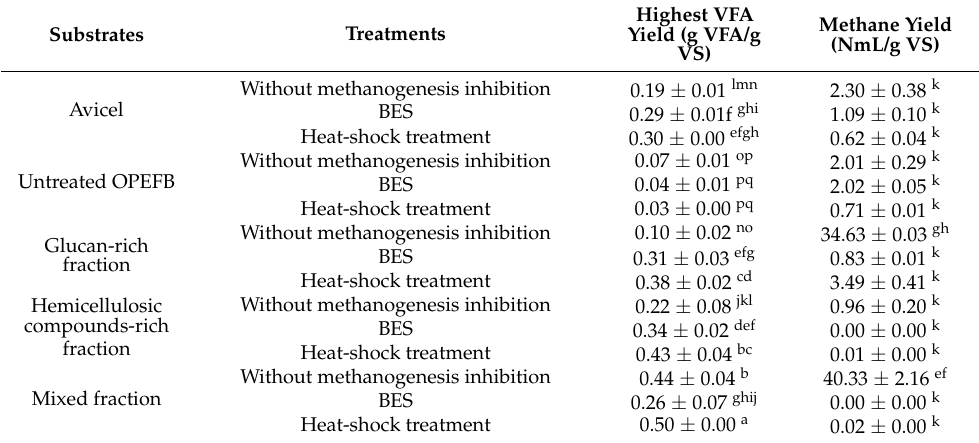
Table 3. Maximum VFAs yield from different substrates with different methanogenesis inhibition methods. The experiments were carried out in